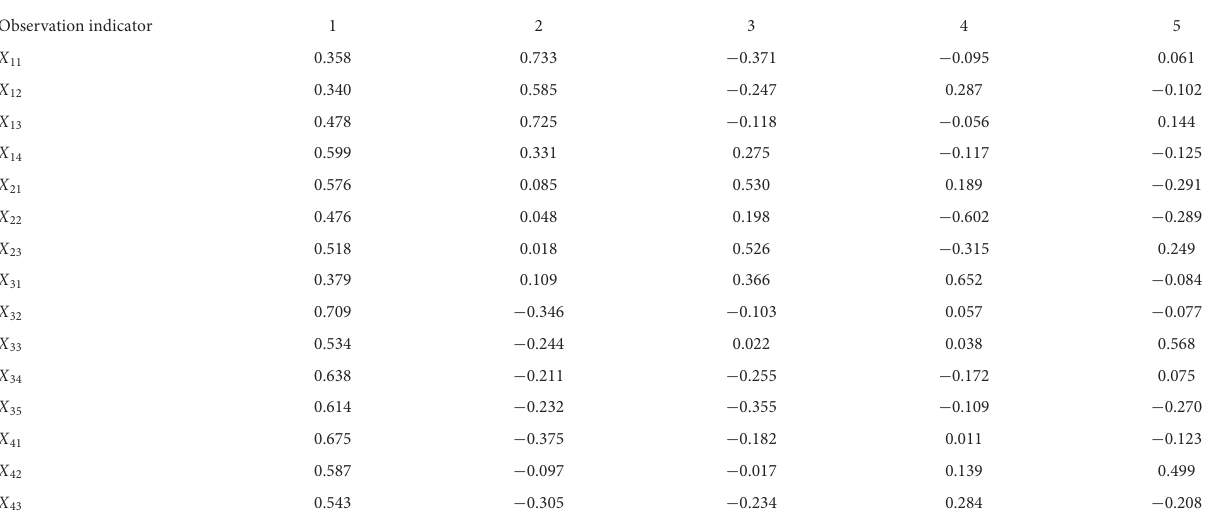
TABLE 6 Component matrix.